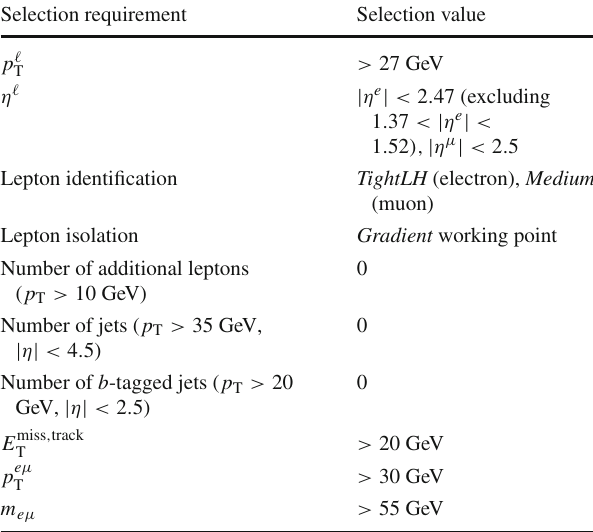
Table 1 Summary of lepton, jet, and event selection criteria for WW candidate events. In the table (cid:5) stands for e or μ . The definitions of lepton identification and isolation are detailed in Refs. [66] and